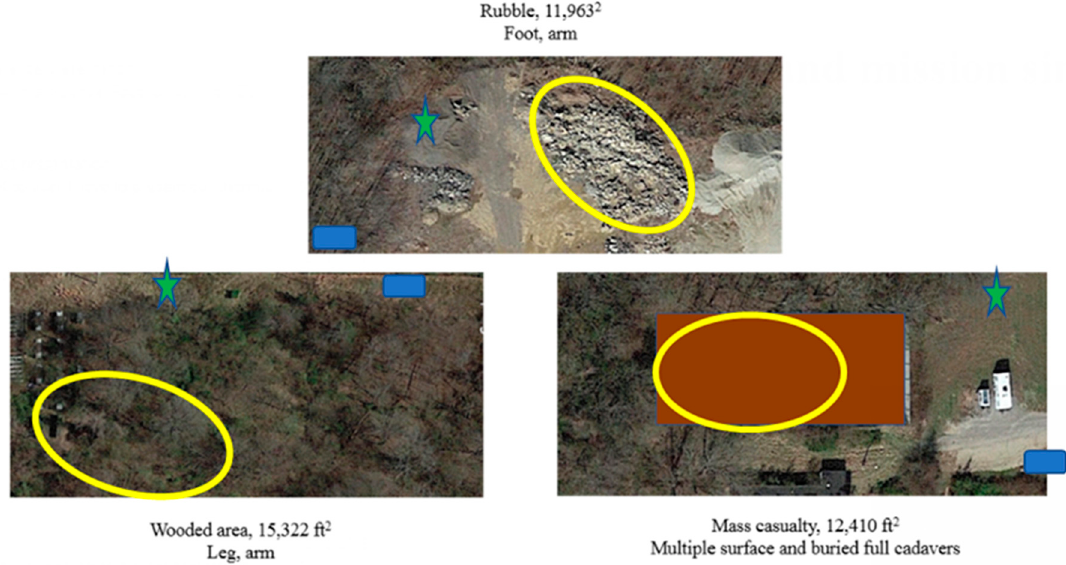
Figure 1. Search environments for human remains detection dogs during a simulated day of tactical deployment operations. Deployment operations consisted of four rotations across three environments with two scenarios at each search environment for a total of eight complete work cycles (WW = waiting-to-work, AW = active work, PWR = post-work recovery) for each canine. Green star = waiting-to-work; yellow circle = active work; blue rectangle = post-work recovery; brown rectangle = For purposes of donor privacy, the mass casualty area has been blurred so as to avoid unintentional identification of donors.